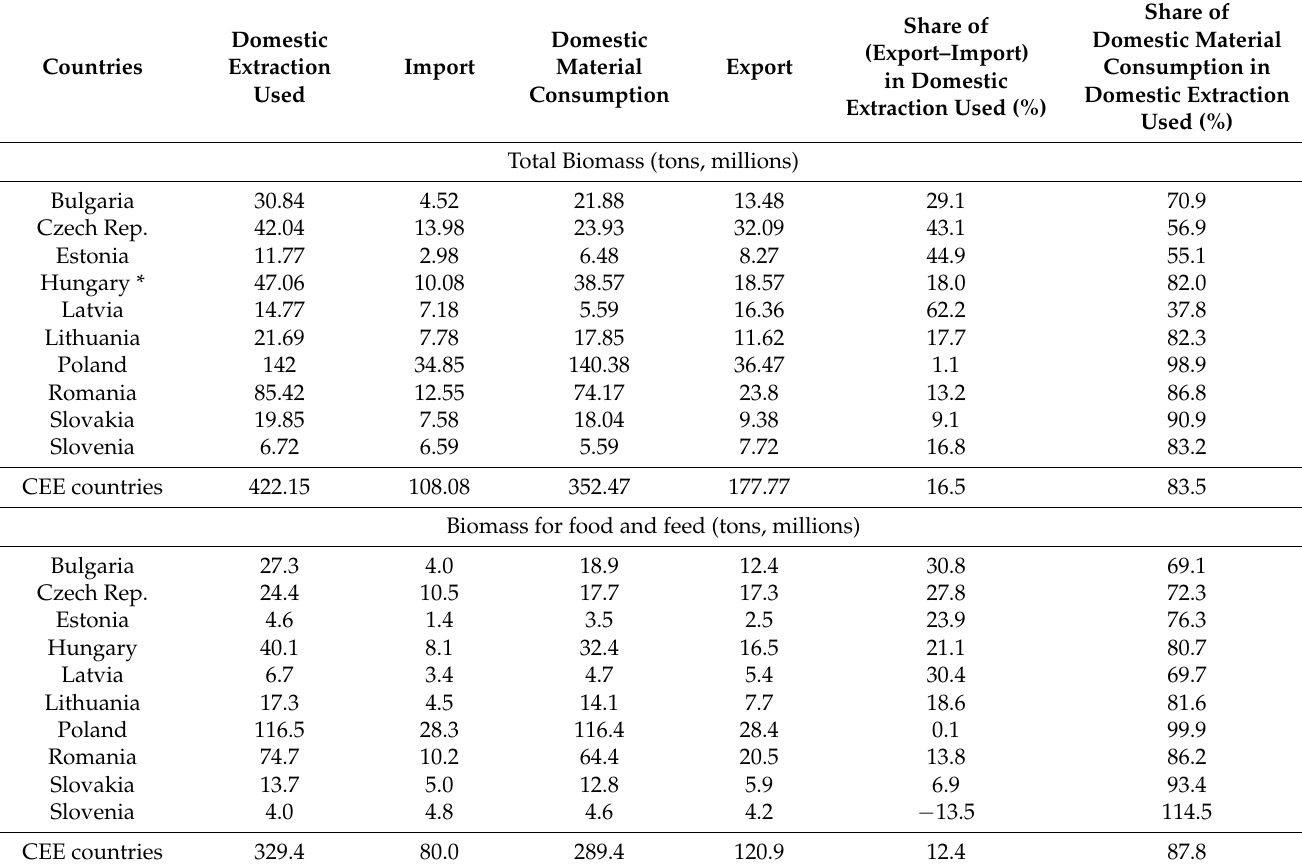
Table 11. The main biomass indicators in 2019 in ten CEE countries.